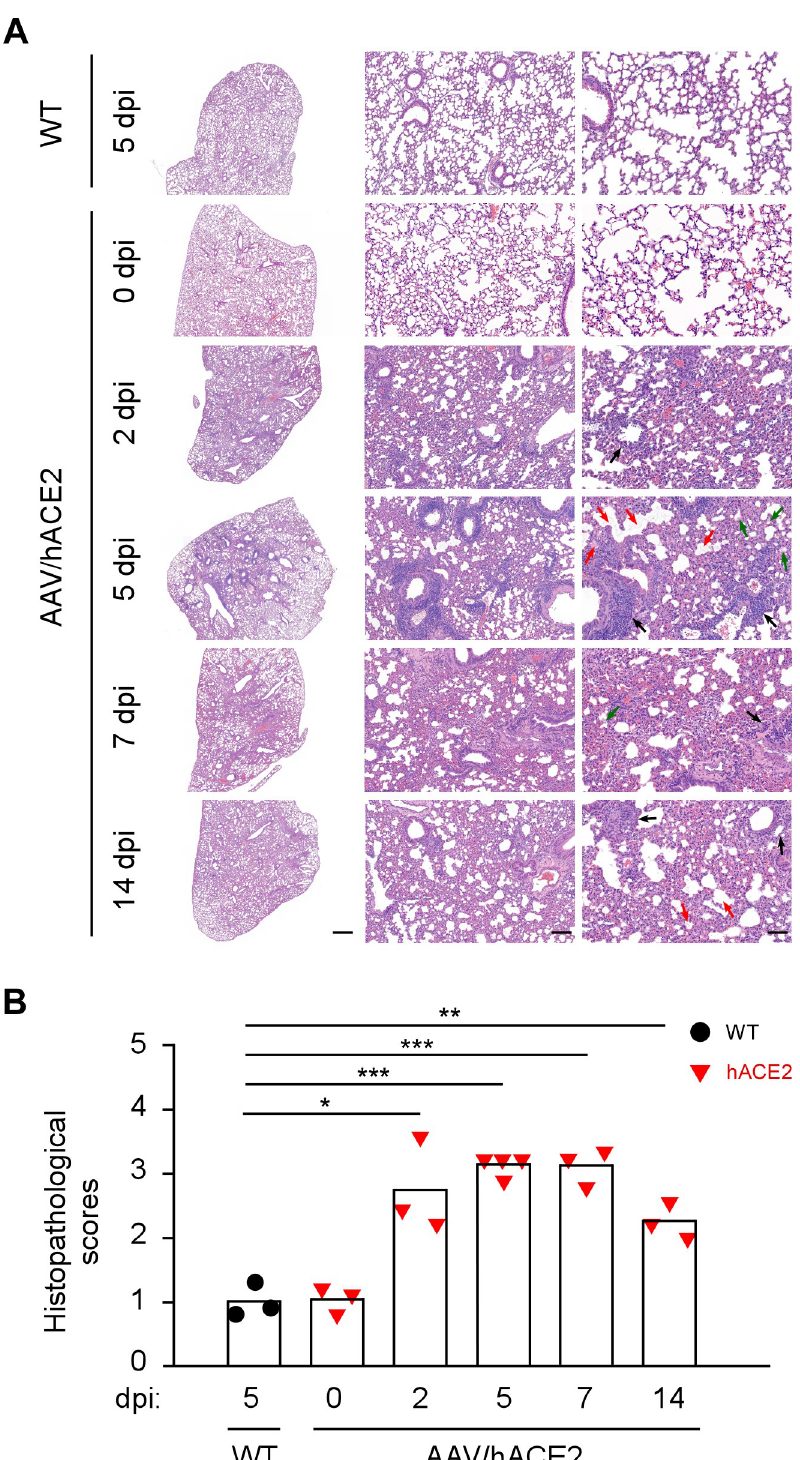
Fig 4. Pathophysiological changes in SARS-CoV-2-infected AAV/hACE2 mice. (A) The lungs of SARS-CoV- 2-infected WT (5 dpi, n = 3) and AAV/hACE2 mice (0, 2, 5, 7, and 14 dpi, n = 3 or 4) were analyzed for pathophysiology by H&E stain examination. Peri-bronchial and peri-vascular inflammatory infiltration (black arrow), fibrin exudate (red arrow), and hyaline membrane formation (green arrow) can be observed in the lungs of challenged AAV/hACE2 mice. Micrographs are presented at low (left panel; scale bar, 1,000 μ m), medium (middle panel; scale